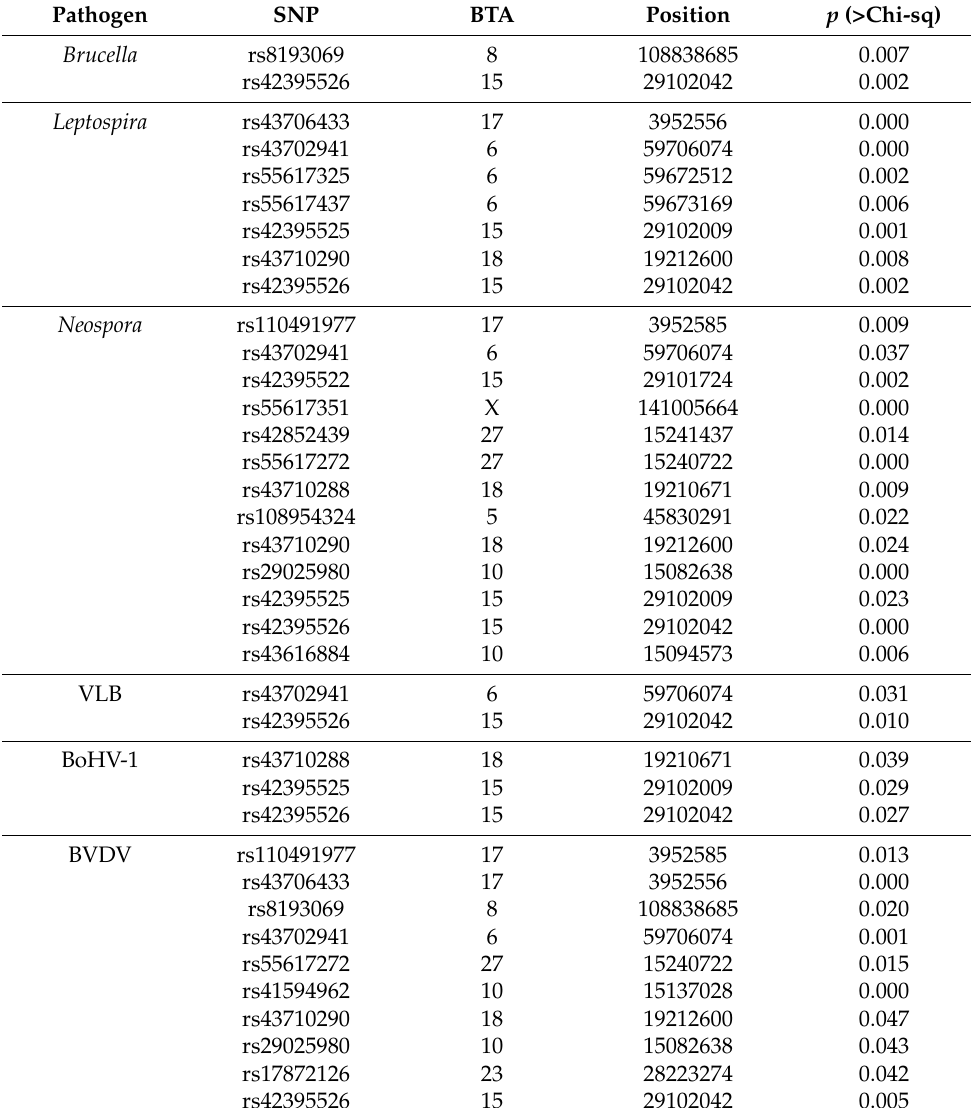
Table 4. Results of univariate analysis between SNPs and serology in Curraleiro P é -Duro